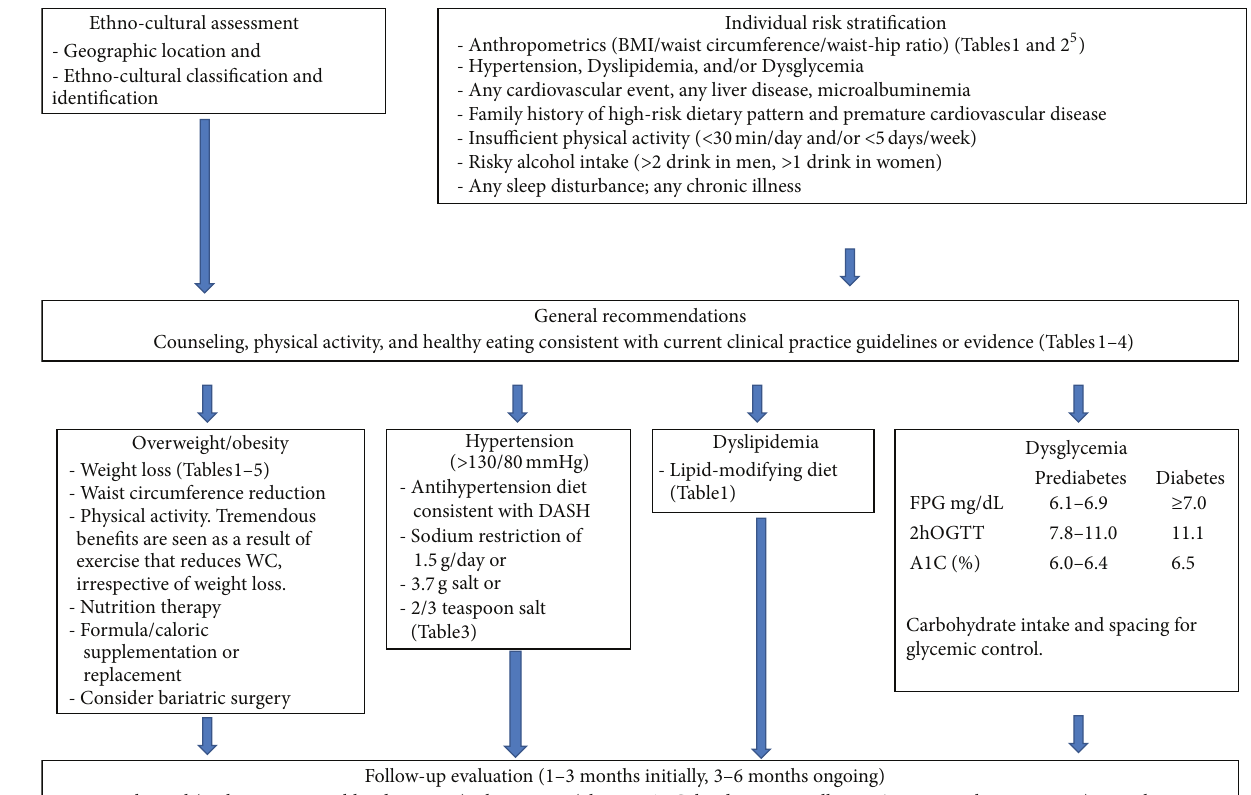
Figure 2: Canadian Transcultural Diabetes Nutrition Algorithm (tDNA) for prediabetes and type 2